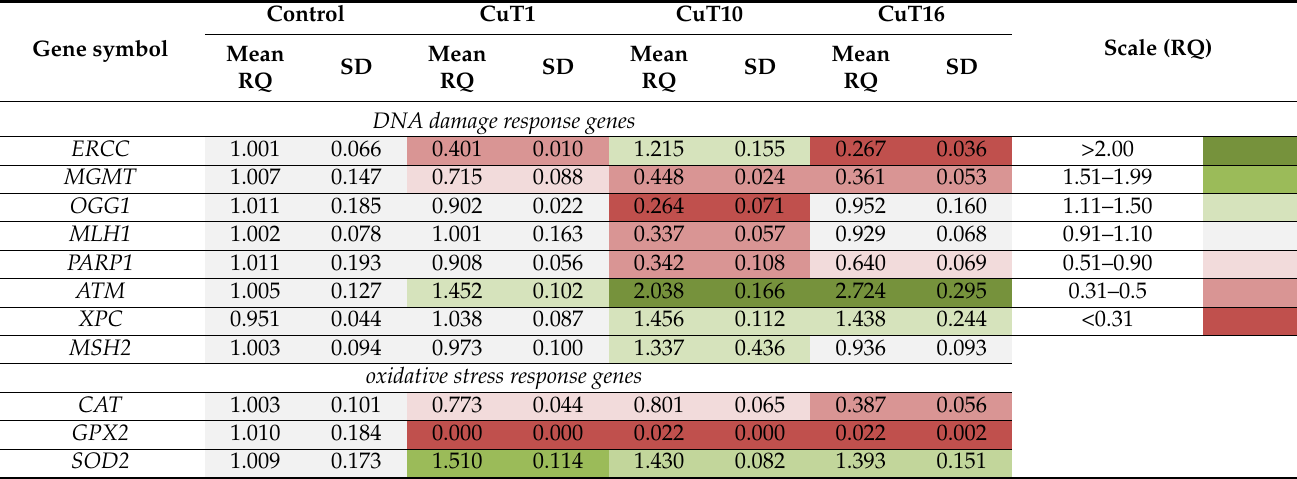
Table 4. The results of mRNA gene expression. Significantly changed mean RQ levels are marked with a color scale.